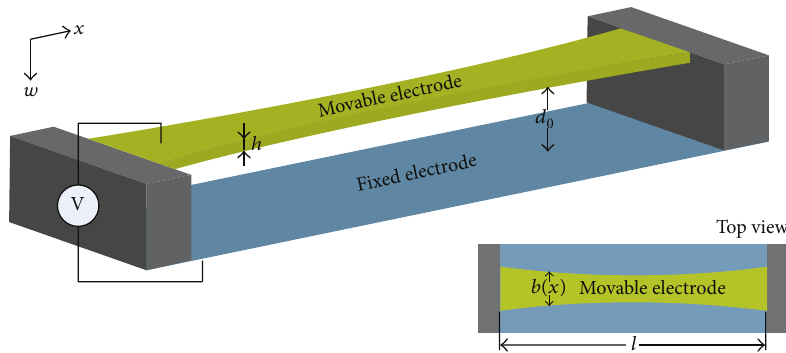
Figure 1: Schematic of an electrostatically actuated variable width fixed-fixed